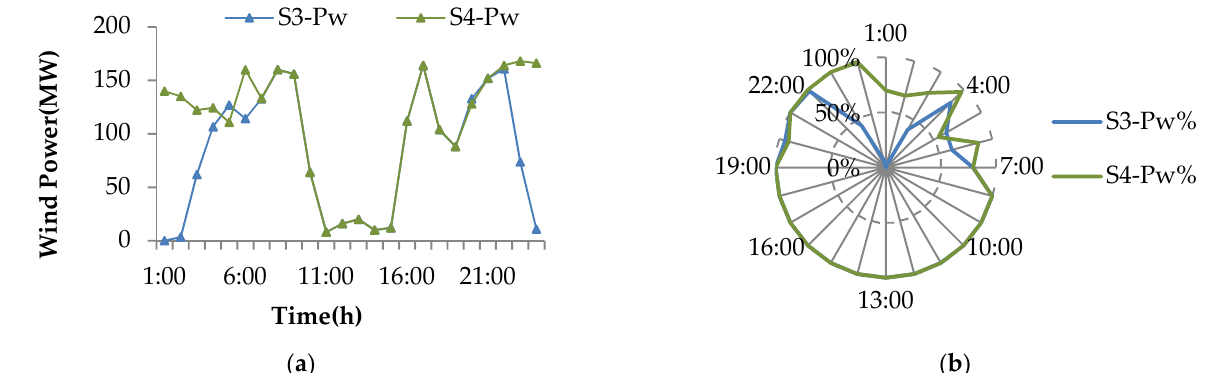
Figure 8. Typical day wind power scheduling results: ( a ) wind power and ( b ) utilization rate.